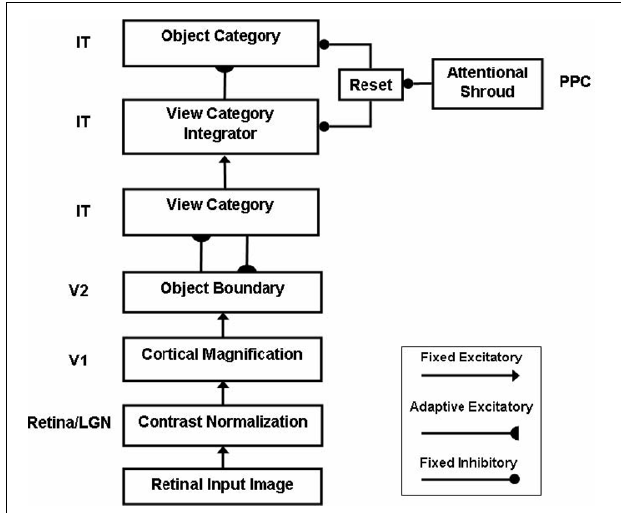
FIGURE 2 | Microcircuit of the pARTSCAN model (Cao et al., 2011; Figure 2). See text for